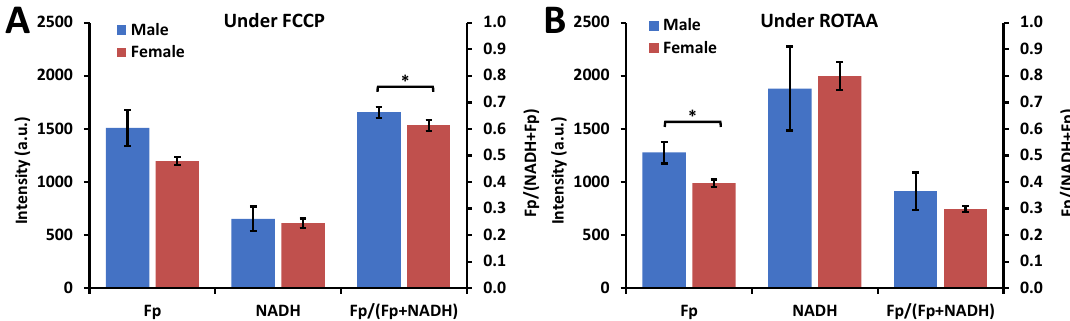
Figure 3. Sex-associated redox difference observed when AM from SP-A2 mice were subject to metabolic stress under the FA condition. ( A ) AM in the oxidized extreme when treated with mitochondrial oxidative phosphorylation uncoupler FCCP; ( B ) AM in the reduced extreme when treated with mitochondrial complex I inhibitor (rotenone, ROT) + mitochondrial complex III inhibitor (Antimycin A) (Mean ± SD). * p < 0.05.